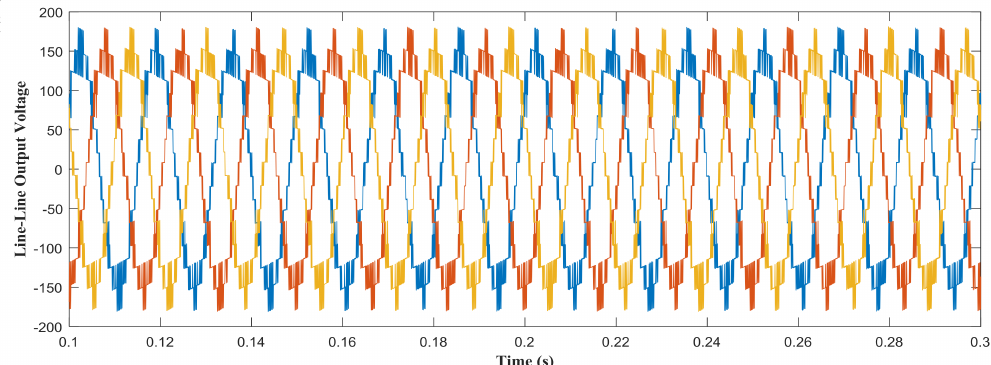
Figure 5. Three-phase line-line output voltage for the proposed converter (blue: V AB ; red: V BC ; yellow: V CA